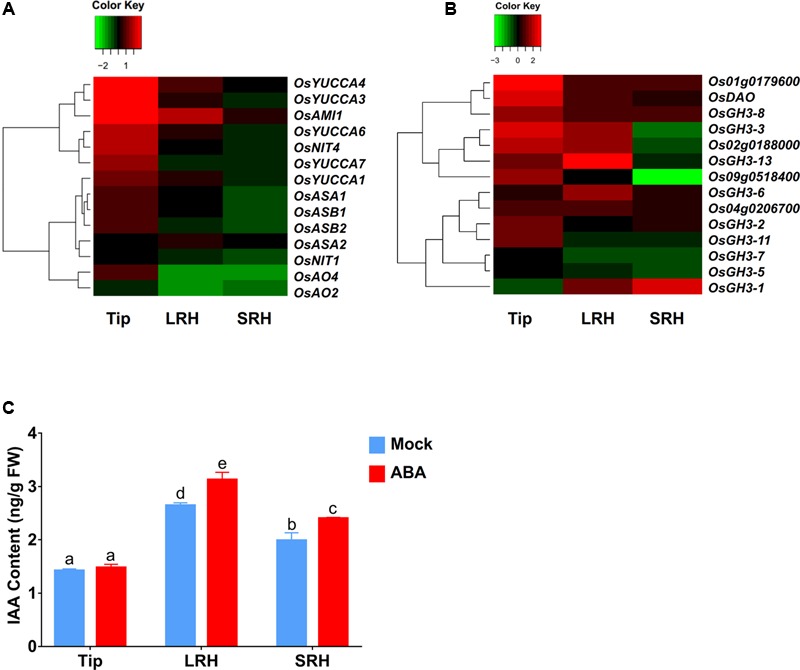
ABA promotes local auxin biosynthesis and accumulation in the LRH zone. (A) Auxin biosynthetic gene expression profile in Tip, LRH, and SRH under ABA treatments. (B) Auxin metabolic gene expression profile in Tip, LRH, and SRH under ABA treatments. (C) Quantification of IAA level in the Tip, LRH, and SRH under ABA treatments.